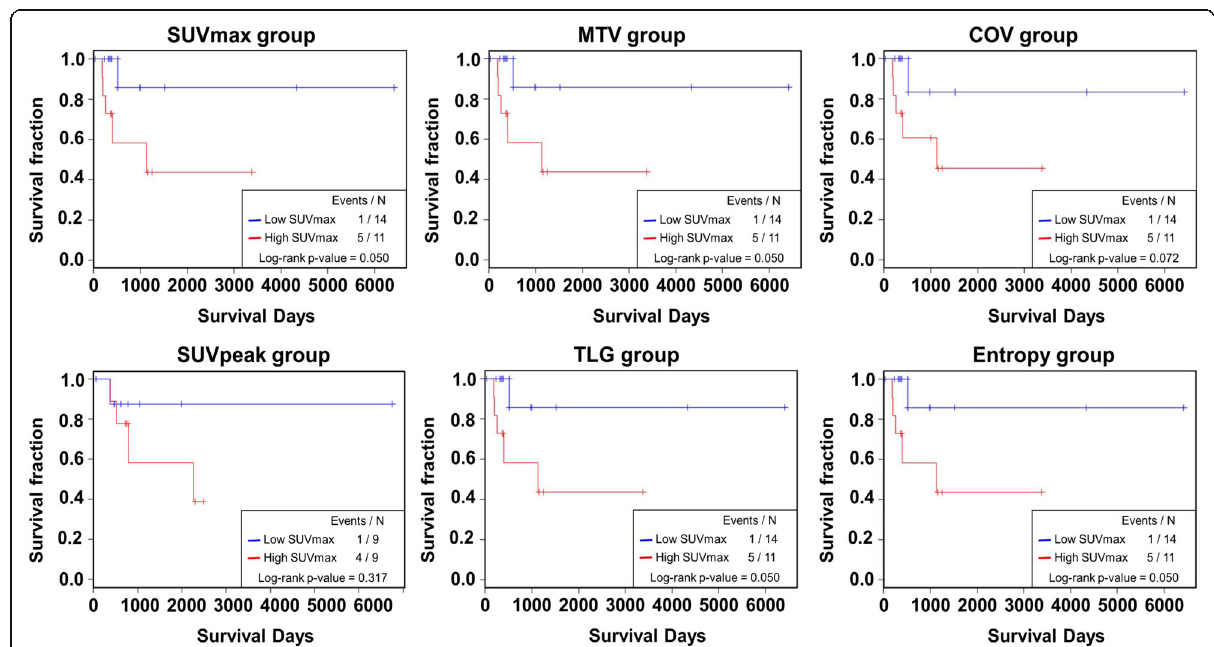
Fig. 5 Prognostic value of FDG PET features. Kaplan-Meier curves of each group divided with adjusted cutoff value of FDG features. Survival analysis and log-rank test were performed to compare each group. Low and high FDG subsets for 25 patients. Red, high subset; blue, low subset. Of note, low and high MATH and GlycoS groups are divided according to the optimized cut-offs obtained by cut-off finder (http://molpath.charite.de/cutoff/index.jsp)